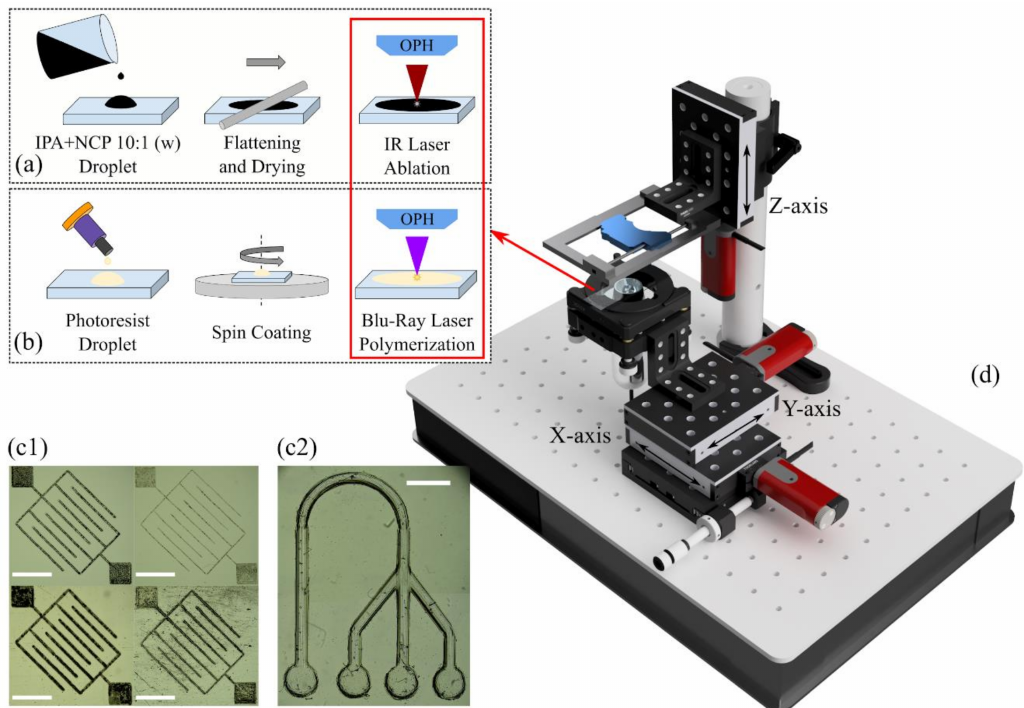
Figure 1. Diagrams of the laser ablation ( a ) and DLW ( b ) microfabrication methods to fabricate microstructures directly in transparent plastics such as PMMA, PDMS, PLA, and Loctite 3525 ( c1 ) or by direct laser writing in Loctite 3525 ( c2 ). Everything was achieved with the benchtop laser platform with two laser wavelengths ( d ). Electronics are not shown for clarity. Scale bars are 1